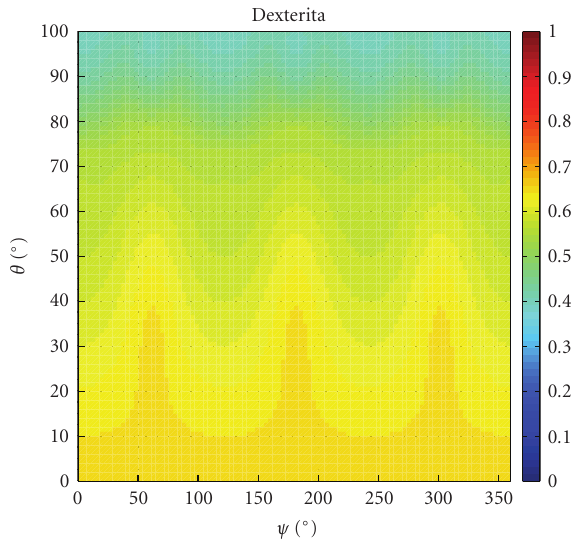
Figure 5: The dexterity of